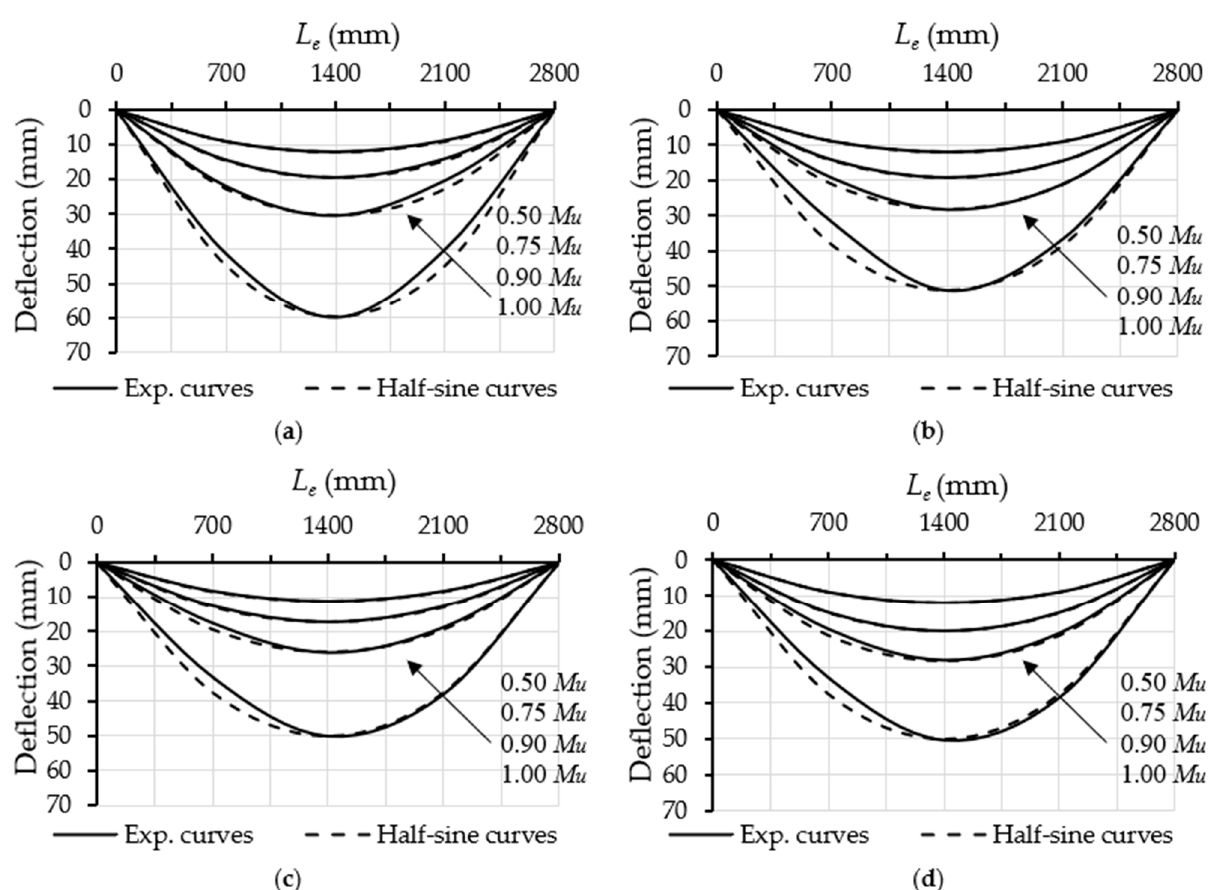
Figure 4. Deflection shapes of the filled specimens: ( a ) FB-RC0; ( b ) FB-RC30; ( c ) FB-RC50; ( d ) FB-RC70.